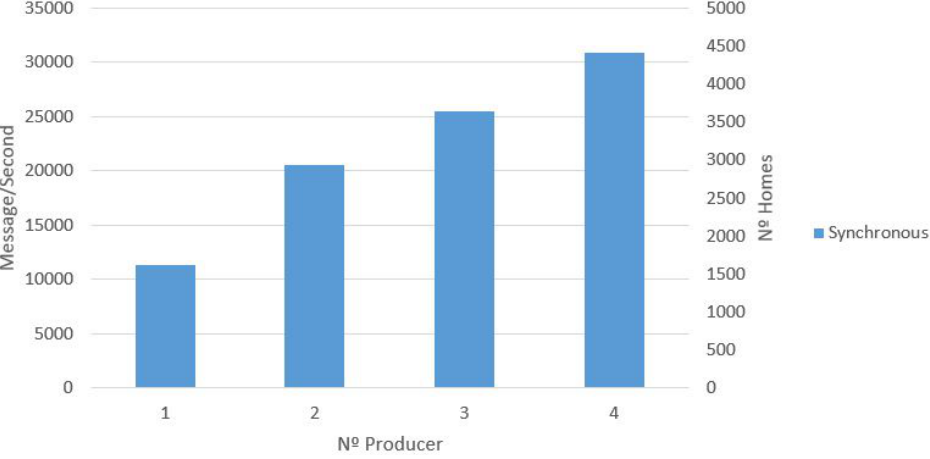
Figure 11. UIoT data producer: synchronous.